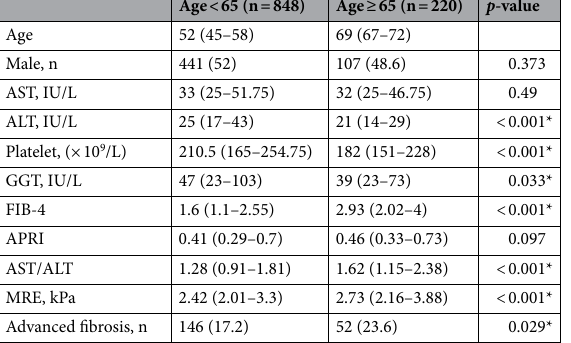
Table 5. Comparison of clinical and laboratory variables based on age. Data are presented as median with interquartile range in parentheses, or numbers of subjects with percentage in parentheses. AST aspartate aminotransferase, ALT alanine aminotransferase, GGT gamma-glutamyl transferase, kPa kilopascals, *are the parameters with p <